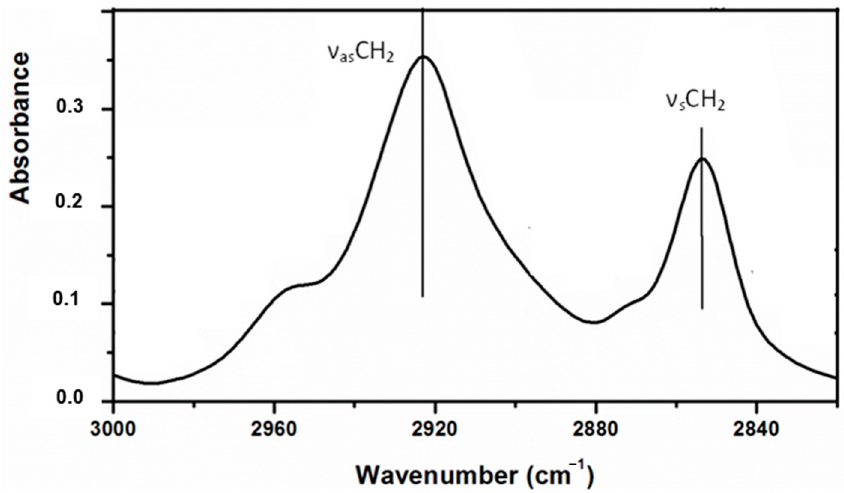
Figure 3. Representative FT-IR spectra in the 3000–2820 cm − 1 region from cooked meat products (type frankfurter).